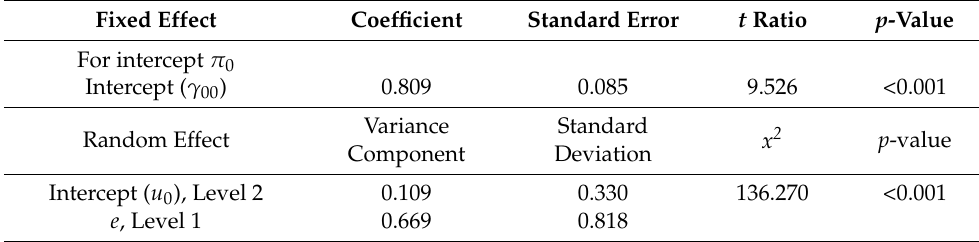
Table 3. Results of the parameter and variance component model of fire occurrence density.